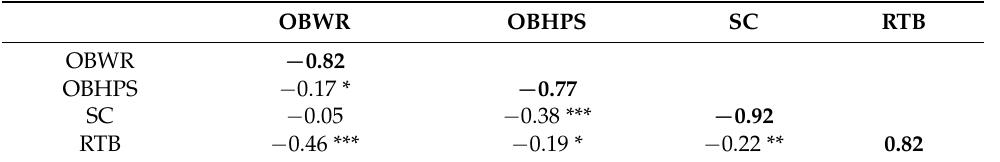
Table 5. Results of the discriminant validity